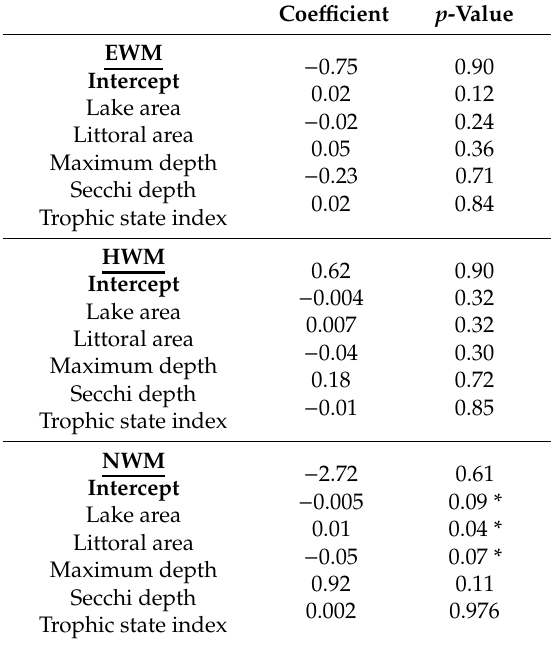
Table 4. Logistic regression analysis (LRA) assessment of Eurasian (EWM), hybrid (HWM), and northern watermilfoil (NWM) presence-absence based on environmental variables. Output includes the model intercept and coe ffi cient and p -value associated with each